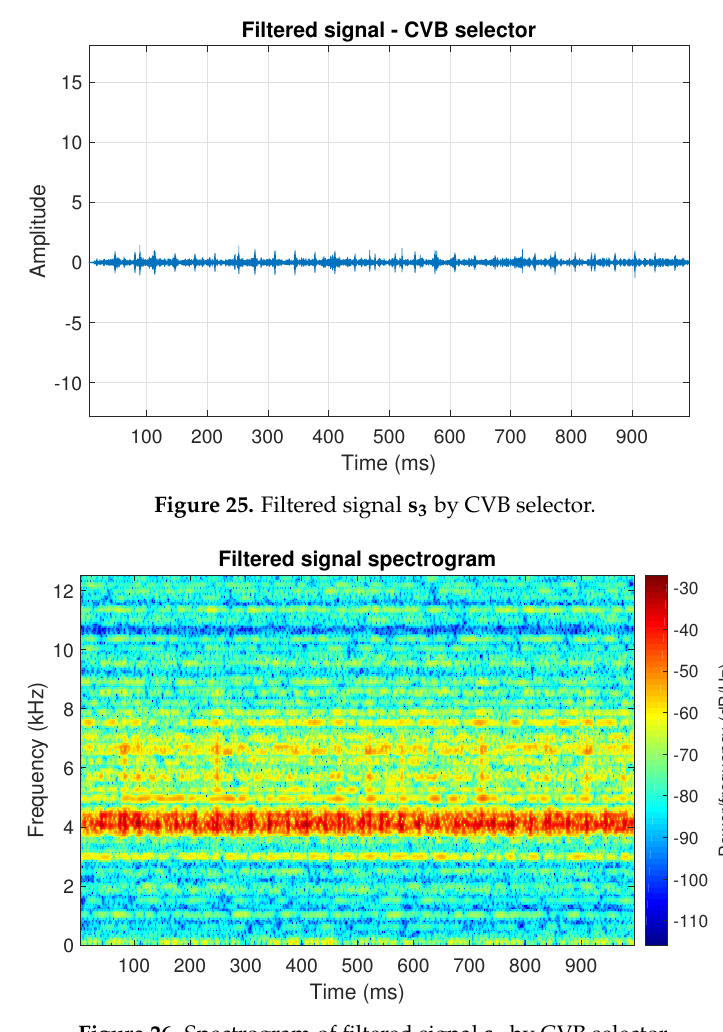
Figure 26. Spectrogram of filtered signal s 3 by CVB